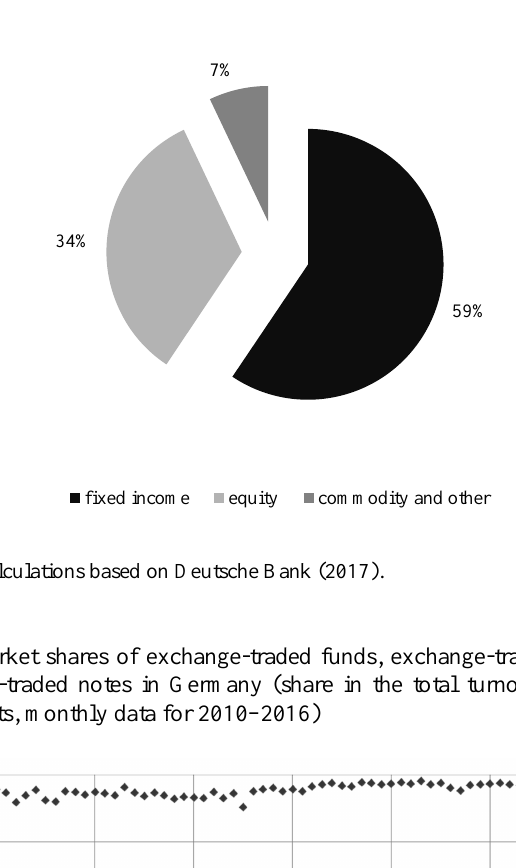
Figure 4. Structure of the European exchange-traded products in terms of asset classes (classified according to cash flows) in 2016